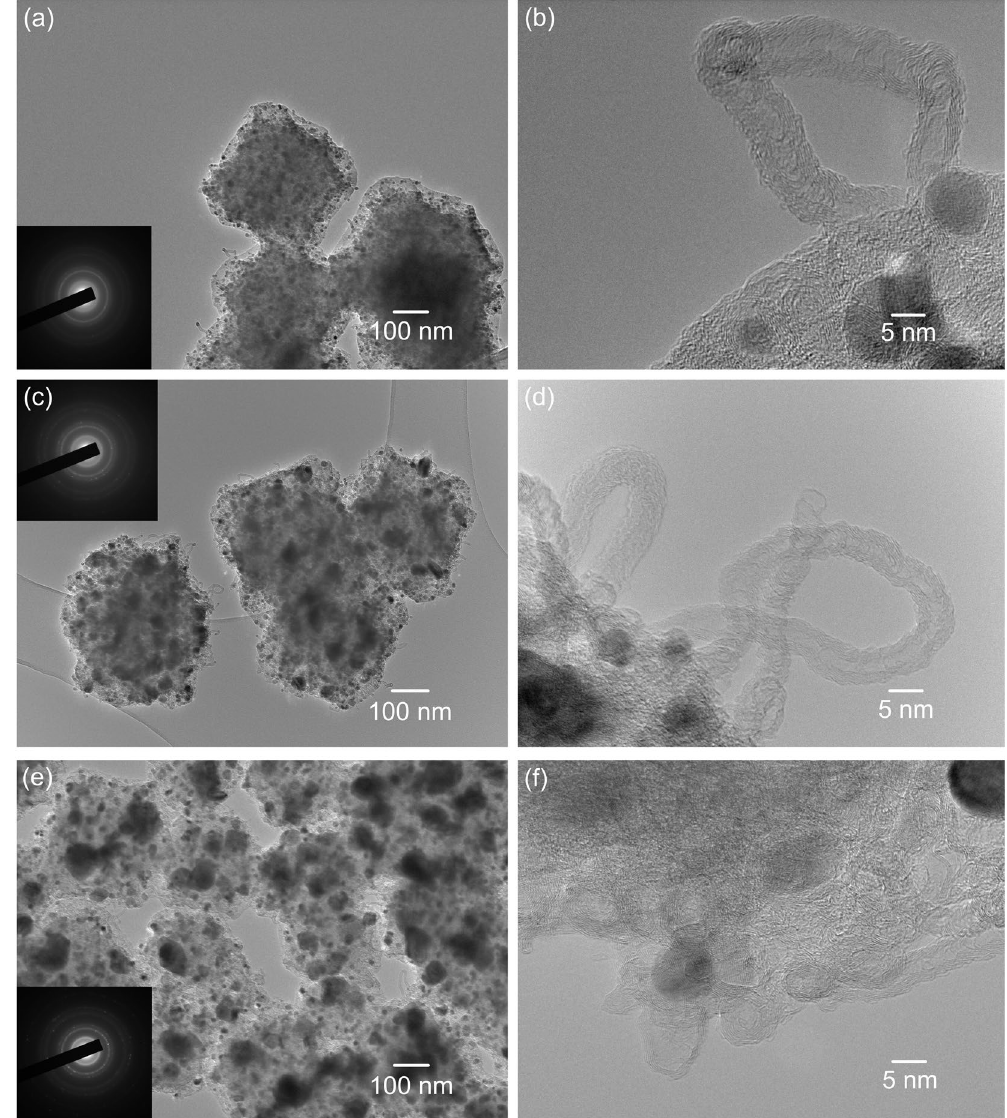
Figure 1. TEM images of the samples generated under relatively low carbonization temperatures: ( a,b ) Co@C- 600; ( c,d ) Co@C-800 and ( e,f ) Co@C-1000. Inset: the SAED patterns for each